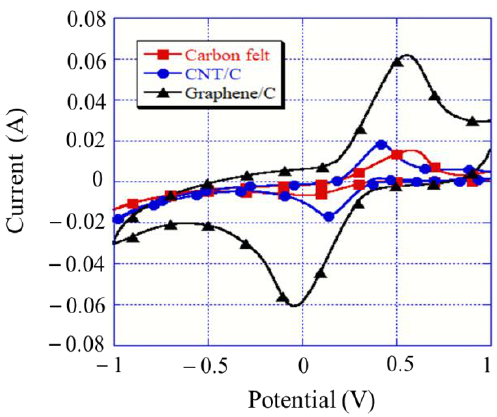
Figure 6. Cyclic voltammetry curves for different modifications of graphite felt.